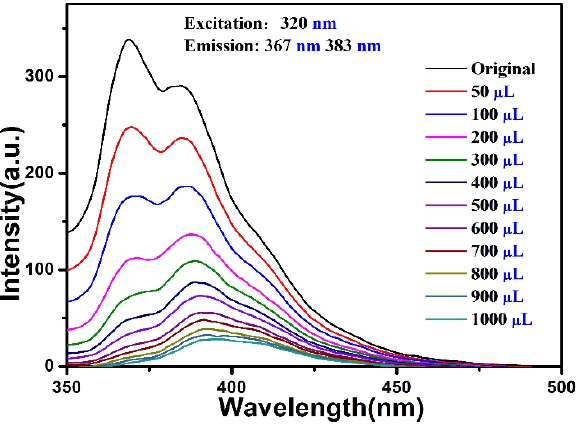
Figure 10. Fluorescence spectra of the compound towards colchicine (5 × 10 − 4 M).